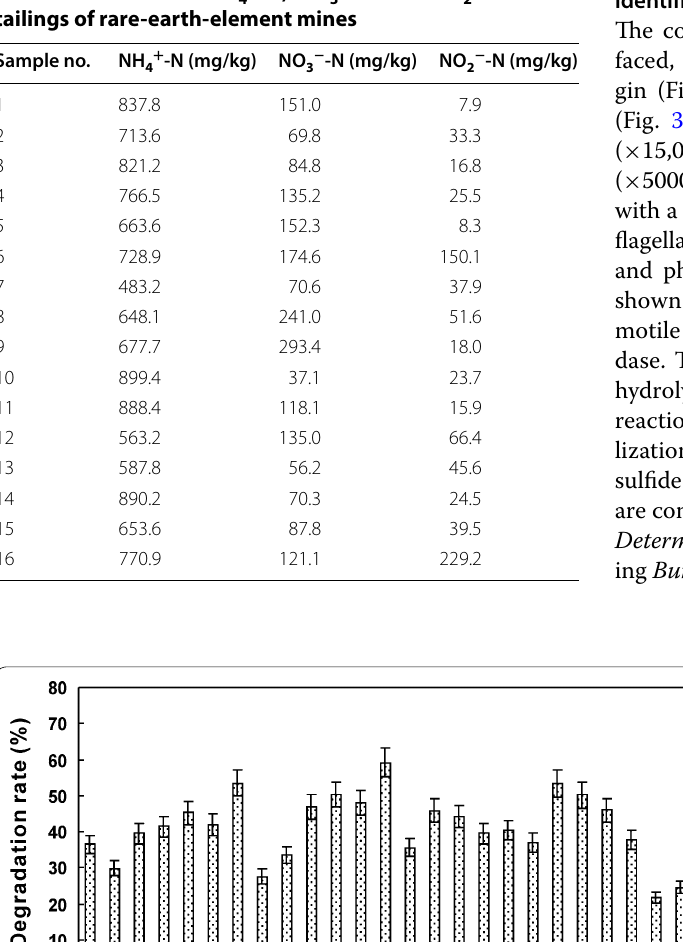
-N, NO -N and NO -N in the 4 + 3 − 2 −